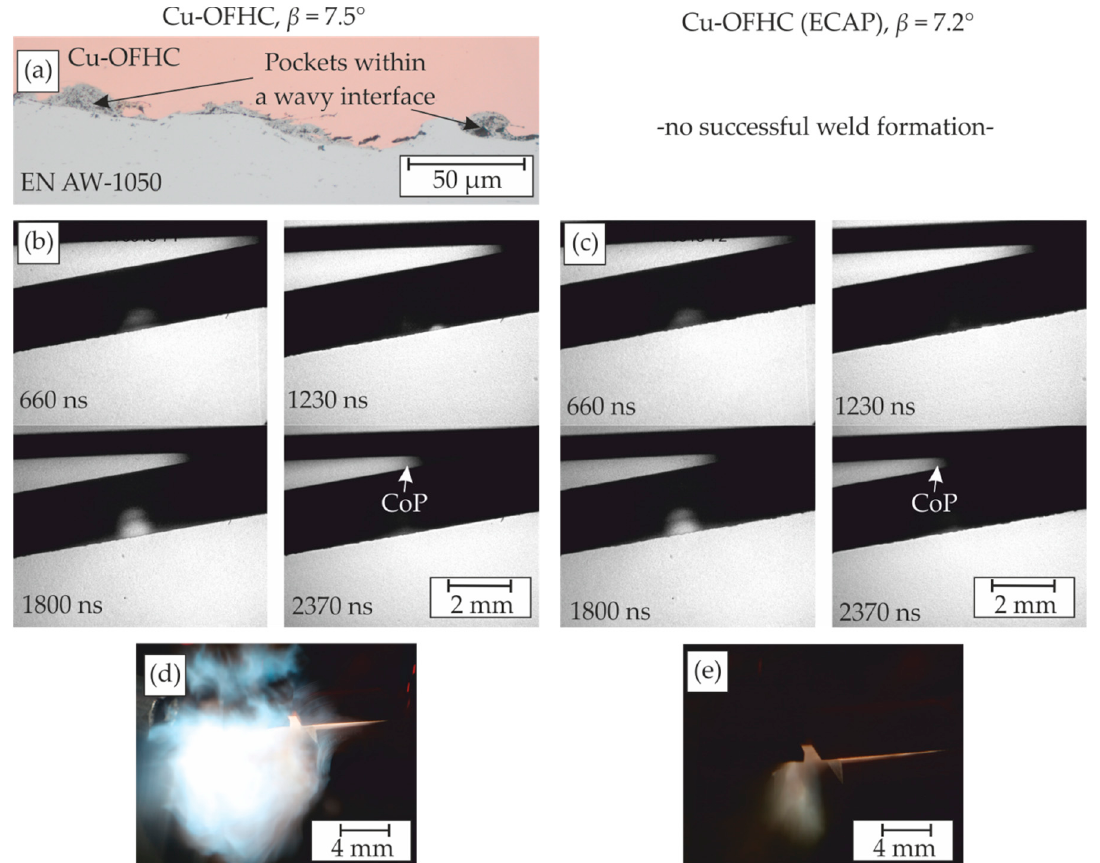
Figure 7. Influence of the parent properties on ( a ) the joining zone in a polished cross section, ( b , c ) the formation of a cloud of particles and ( d , e ) the process glare. Welding direction to the left from the initial collision point.